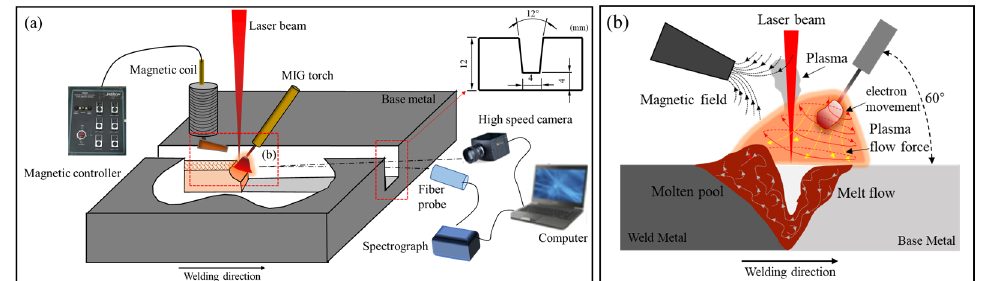
Figure 2. The schematic diagram of the alternating magnetic field assisted laser-MIG hybrid welding: ( a ) schematic diagram of welding equipment and ( b ) schematic diagram of welding process.